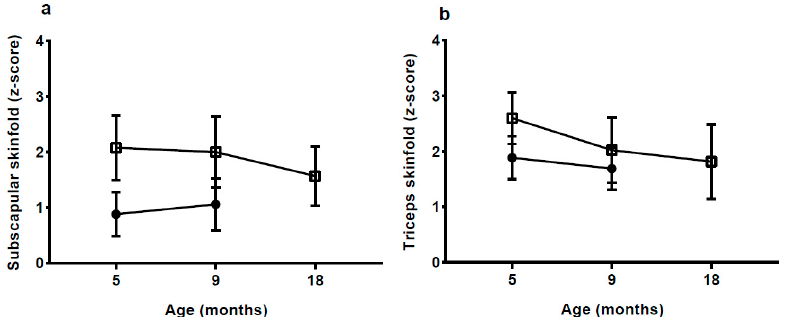
Figure 2. Subscapular and triceps skinfold z -scores according to groups, presented as mean and 95% confidence interval at 5 months (mo) (high weight gain group (HW) n = 13; normal weight gain group (NW) n = 17), 9 mo (HW n = 12; NW n = 17) and 18 mo (HW n = 9; NW n = 0). Data at 18 mo were not available for the NW group. HW = □ NW = ● .